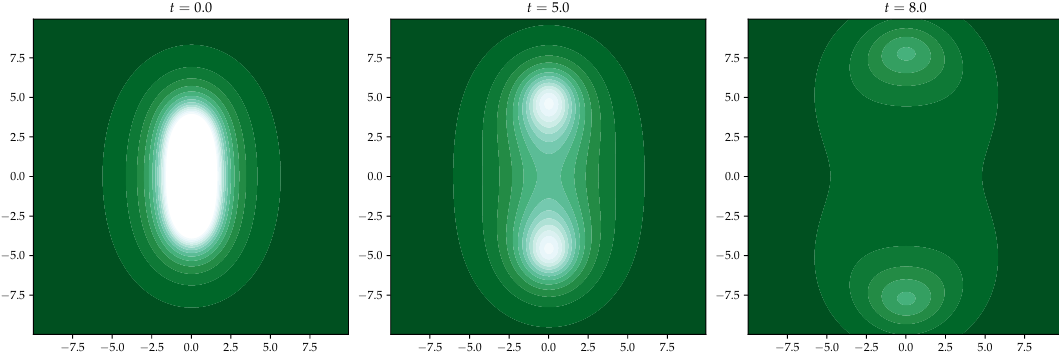
Figure 1 . Three snapshots of the energy density profile (2.34), as sagittal projection. The free propagation shows two “blobs” of radiation traveling along the z axis and meeting close to the origin as t → 0 . The two parameters a 1 and a 2 control the spread of each blob away from the symmetry axis and the astigmatism as the two blobs